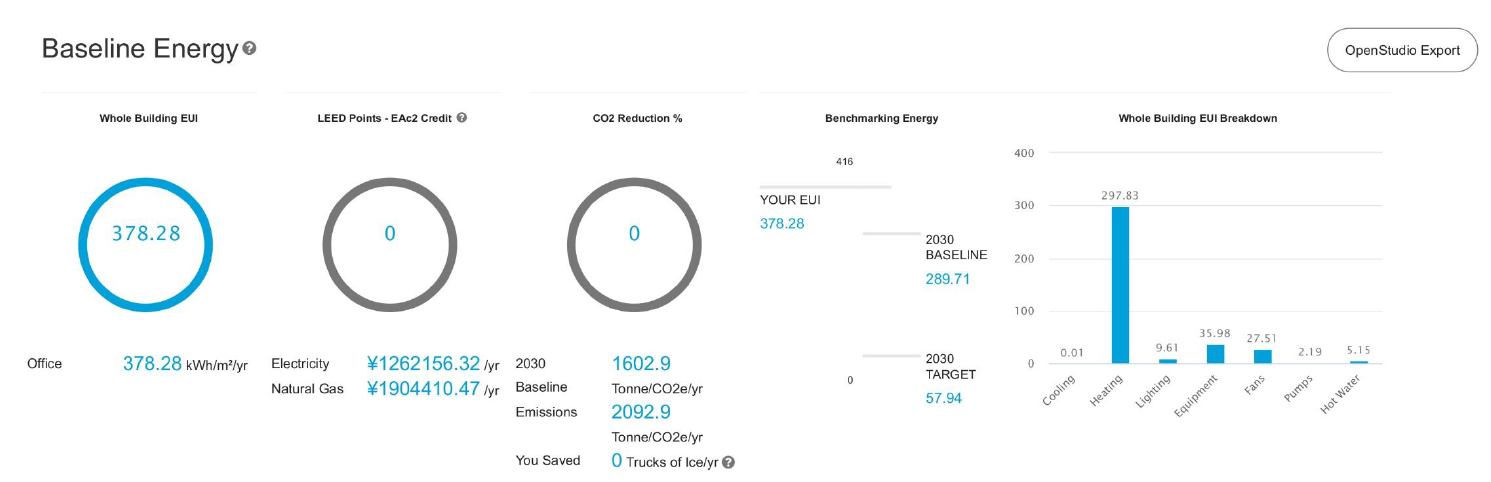
Clean Technol. 2022 , 4 , FOR PEER REVIEW Figure A19. Zone 4-H Chamdo, Xizang (pre-COVID-19 scenario). Figure A19. Zone 4-H Chamdo, Xizang (pre-COVID-19 scenario).